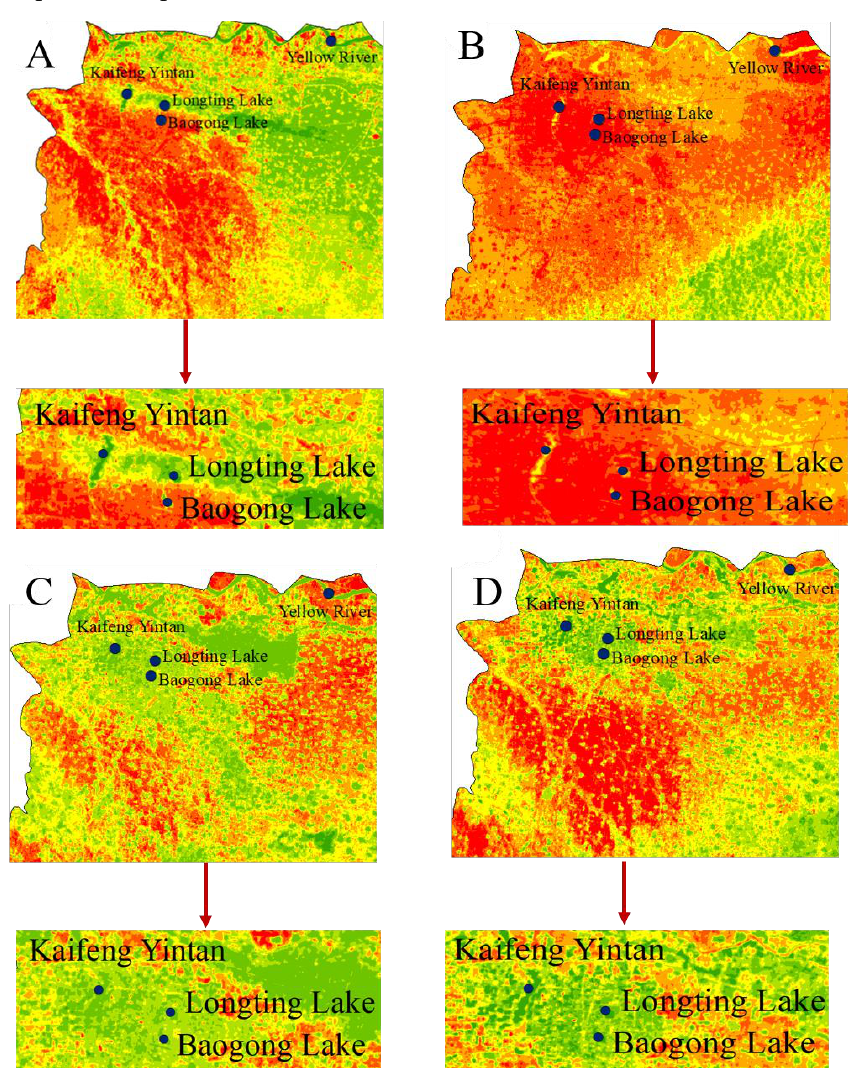
Figure 4. The distribution of LST in the main city corresponding to different times and the corre- sponding LST of Kaifeng Yintan, Longting Lake, and Baogong Lake. ( A ): 2017.05.07; ( B ): 2017.07.10; ( C ): 2017.10.30; ( D ): 2017.12.17.